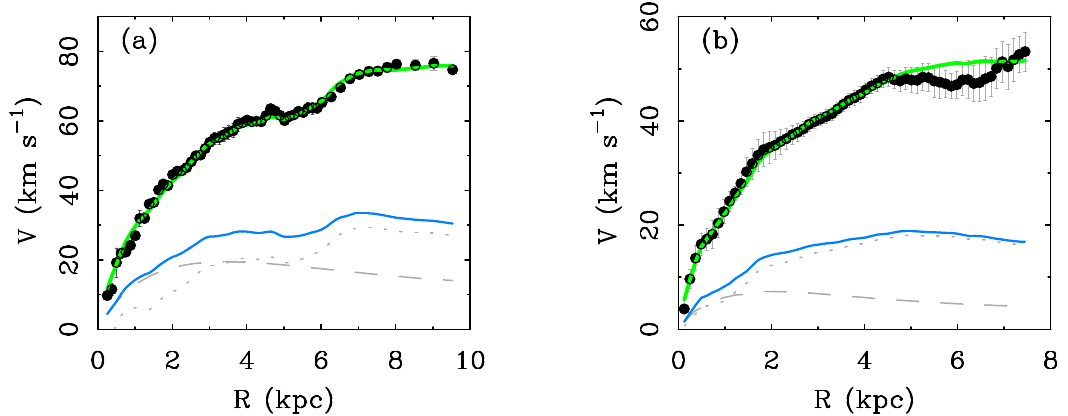
Figure 8. Rotation curves and mass models for the dwarf galaxies ( a ) NGC 1560 [22,33,128] and ( b ) DDO 154 [91,112,116]. The MOND fits (green lines) necessarily follow the detailed shape of the features seen in the baryonic mass distributions (light blue lines). Gas (dotted lines) dominates the mass budget in these low surface density galaxies; the stars (dashed lines) and their mass-to-light ratio have little leverage on the